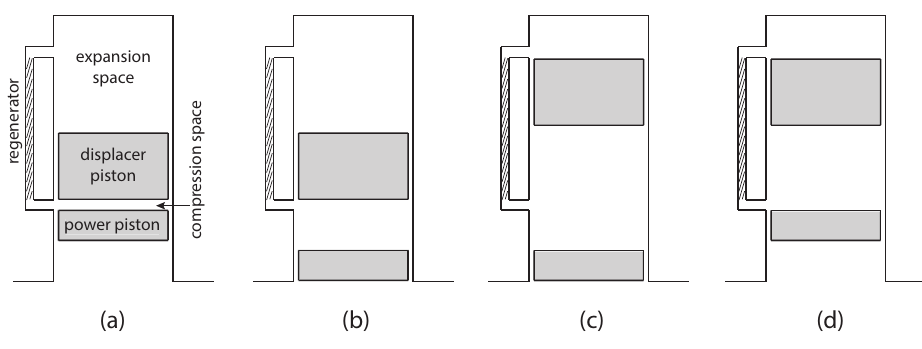
Figure A4. ( a – d ) Working principle of a SE (modified from [48]).